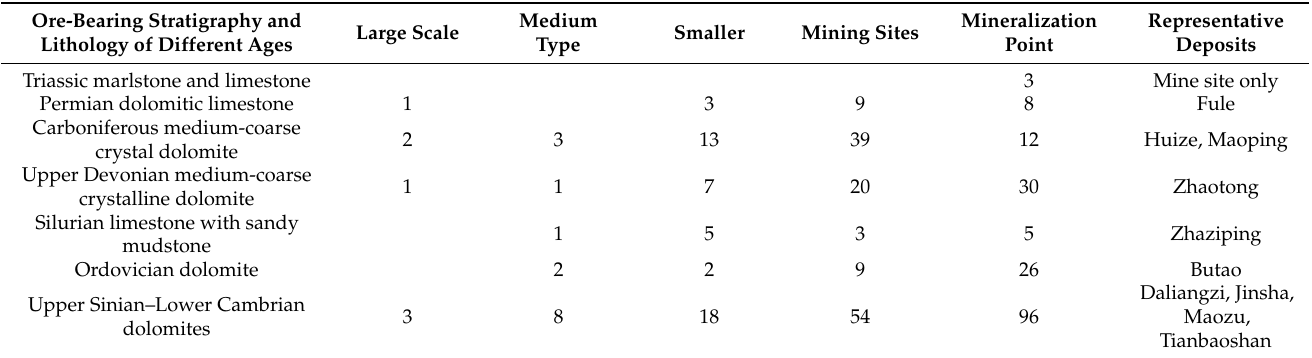
Table 1. Statistical table of the main host strata of the Pb–Zn deposits in the Sichuan–Yunnan–Guizhou area (modified from [29]).